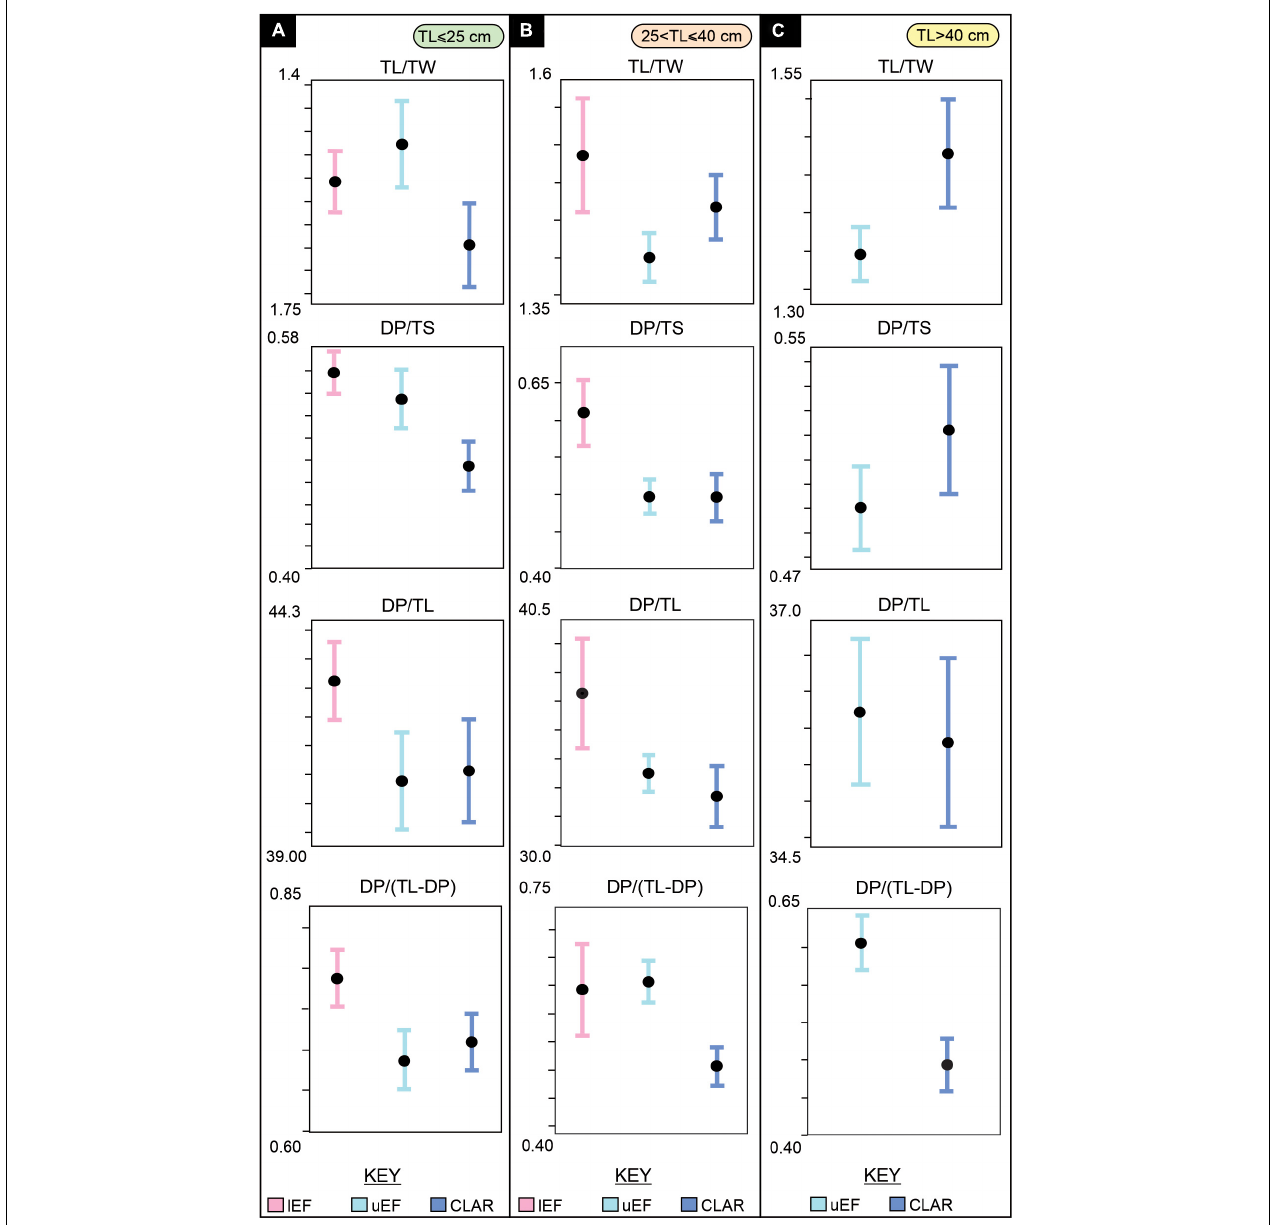
FIGURE 6 | Size grouping trends across the stratigraphic units of the upper Stromberg Group. (A) TL ≤ 25 cm, due to limited sample size “small” track data are merged with “medium” track data, (B) 25 < TL ≤ 40 “large” tracks, (C) TL > 40 cm “mega” tracks. lEF – lower Elliot Formation, uEF – upper Elliot Formation, CLAR – Clarens Formation, TL – track length, TW – track width, DP – digit III projection, TS – track